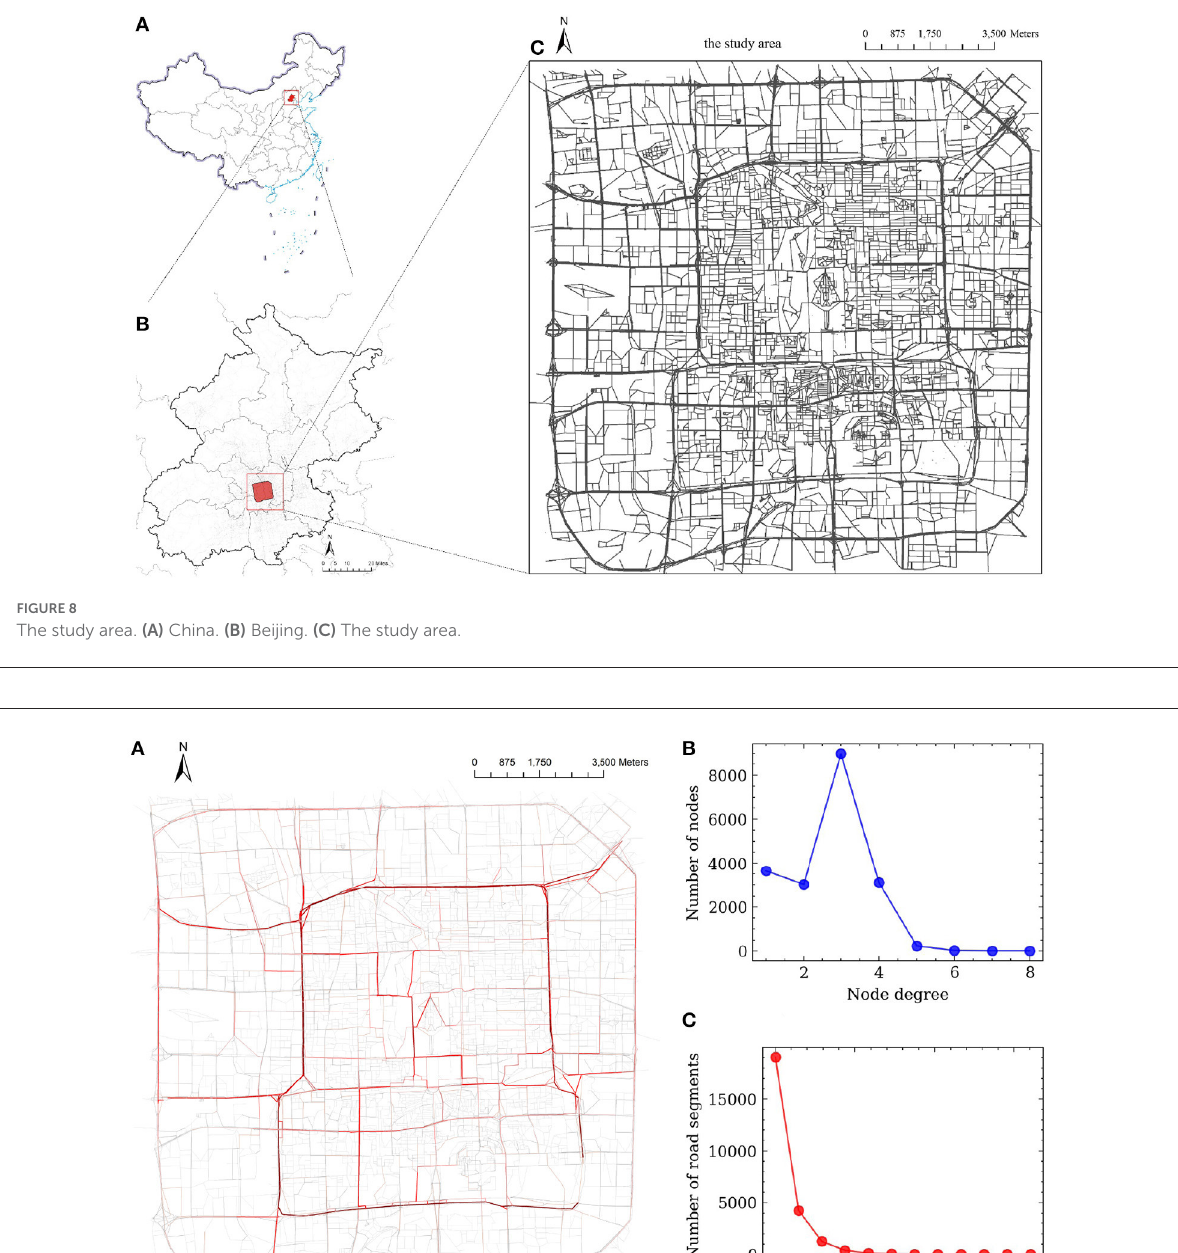
construction and simulation settings). The time-dependent evolving processes of the susceptible group, infected group, and reopened group are shown in Figure 10A. The results of the SIR model indicate that the number of susceptible road segments gradually decreases at the beginning as the disease